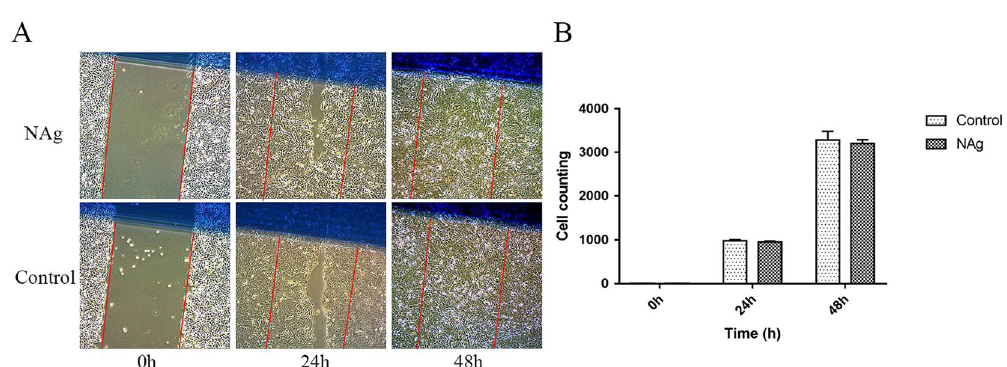
Figure 3. NAg did not prevent HaCaT cells from growth and migration. ( A ) Scratch assay of HaCaT treated with NAg for 0, 24, and 48 hours. ( B ) The relevant counting of cells in scratch area. * Indicates a statistically significant difference, P <